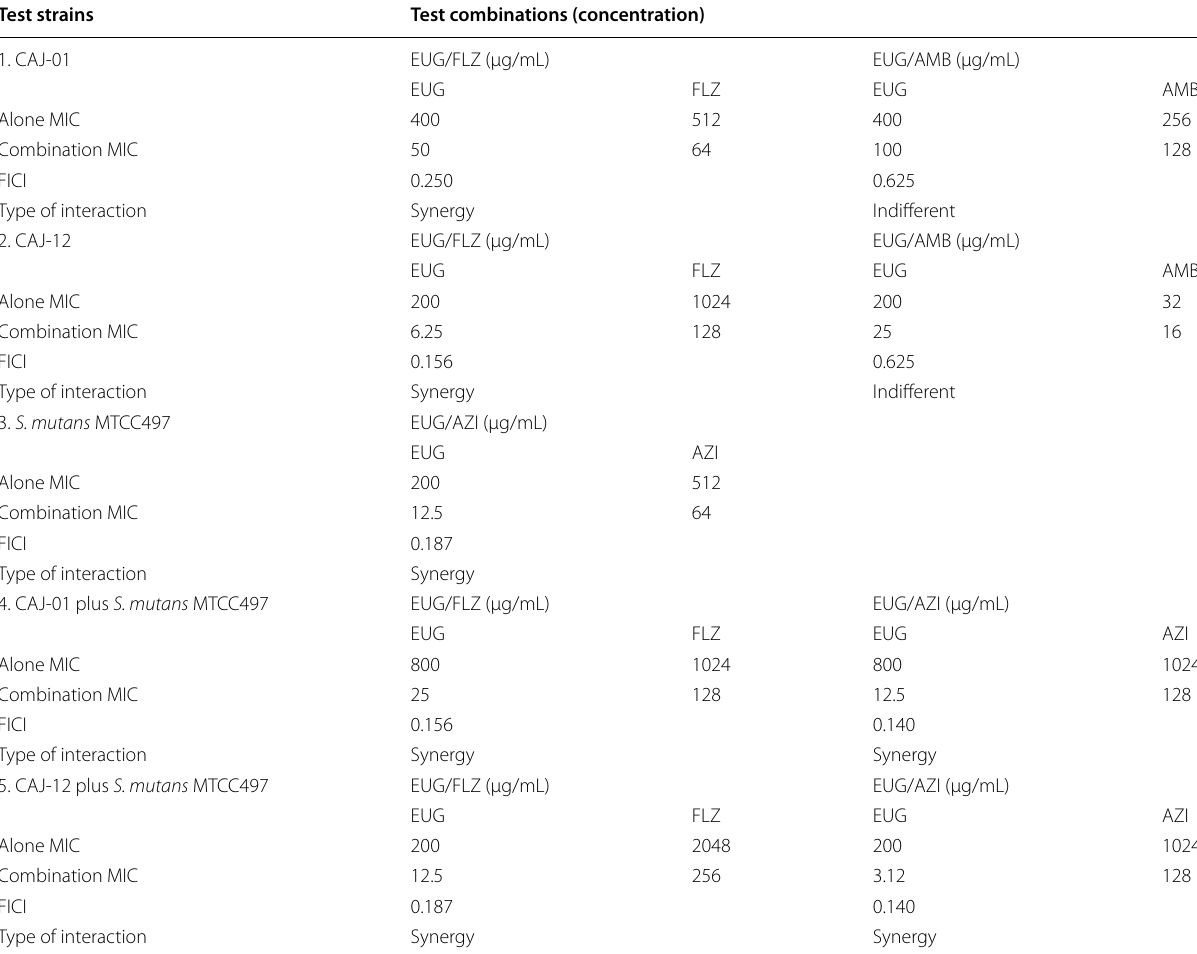
Table 2 Combinational effects of eugenol and antimicrobial drugs on pre-formed C. albicans and S. mutans MTCC497 single and mixed